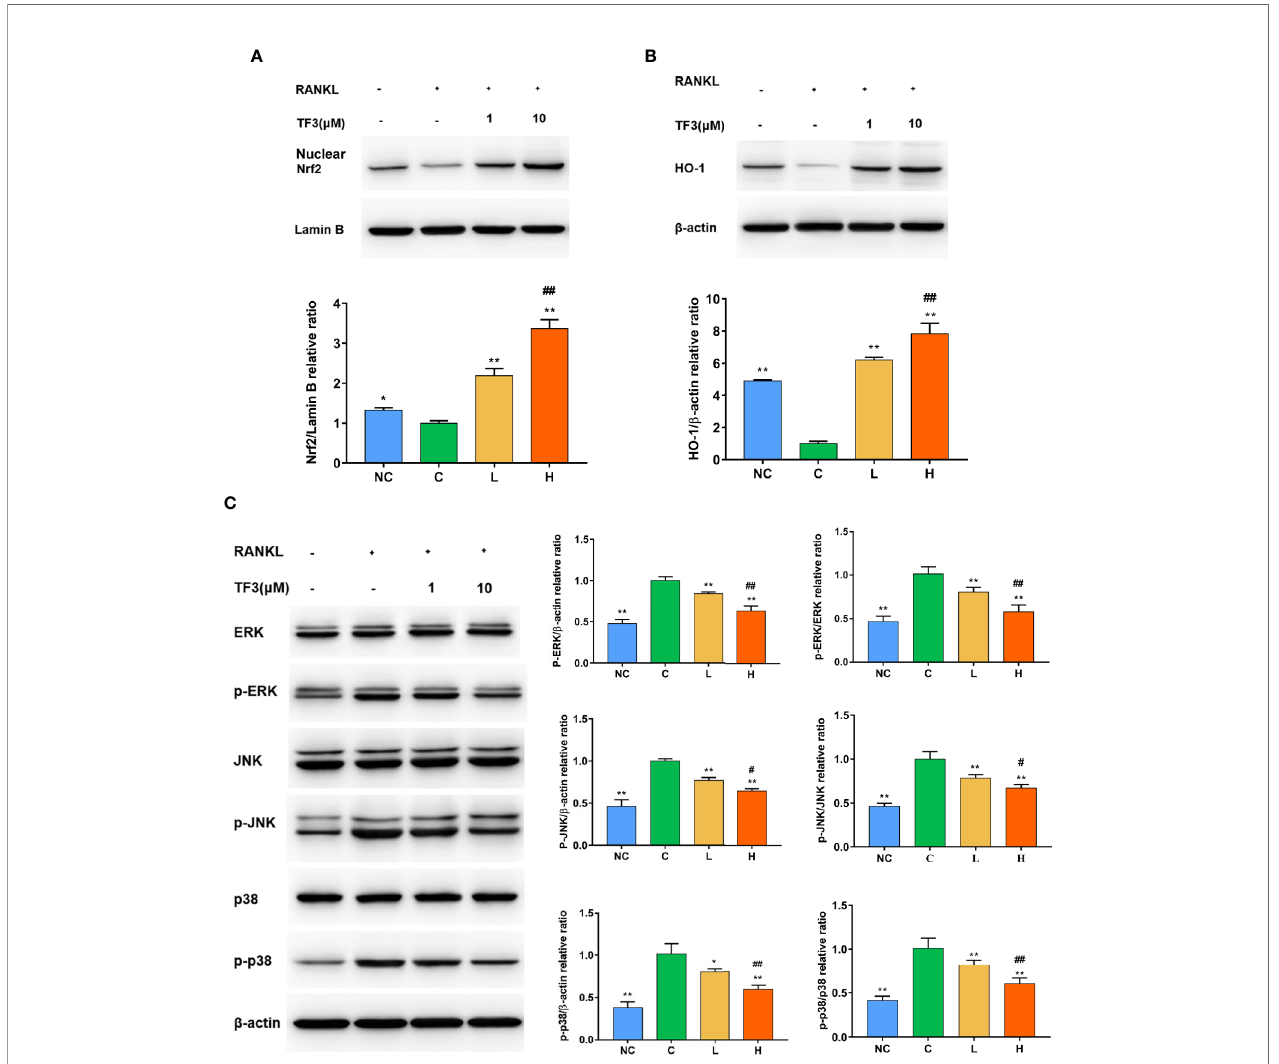
FIGURE 4 | TF3 activated the Nrf2/HO-1 signal pathway and inhibited RANKL-induced phosphorylation of the MAPK pathway. (A) The effects of TF3 on the expression of Nrf2 in nucleus. (B) The in fl uences of TF3 on the expression of HO-1. (C) The effects of TF3 on the MAPK pathway. n = 3, * P < 0.05, ** P < 0.01 compared with C group. # P < 0.05, ## P < 0.01 compared with L